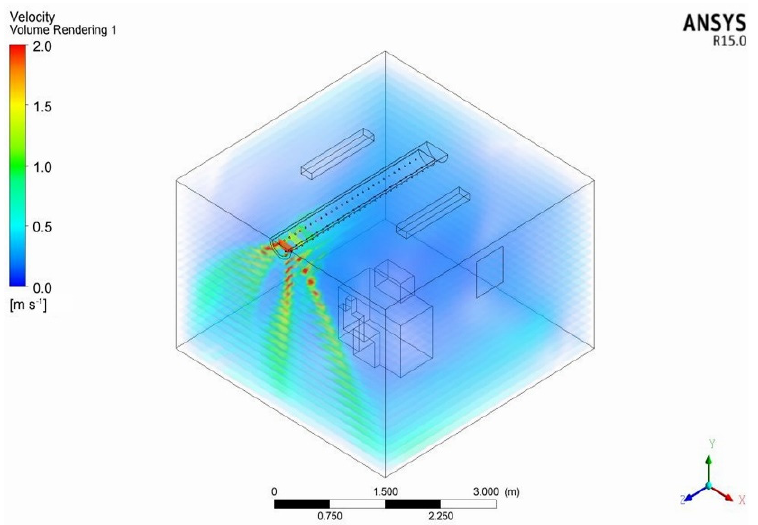
Figure 18. The schematic diagram of the air supply of the split-fiber distribution air conditioner at the upper air outlet.